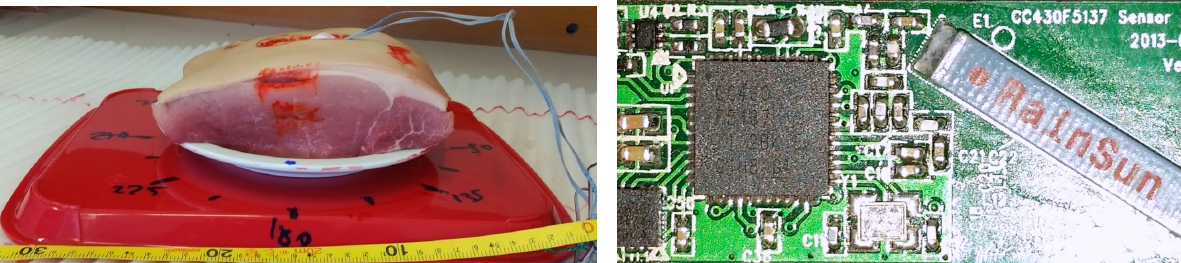
Figure 2: A dissected part of pig tissue used for experimenting with implant communication.